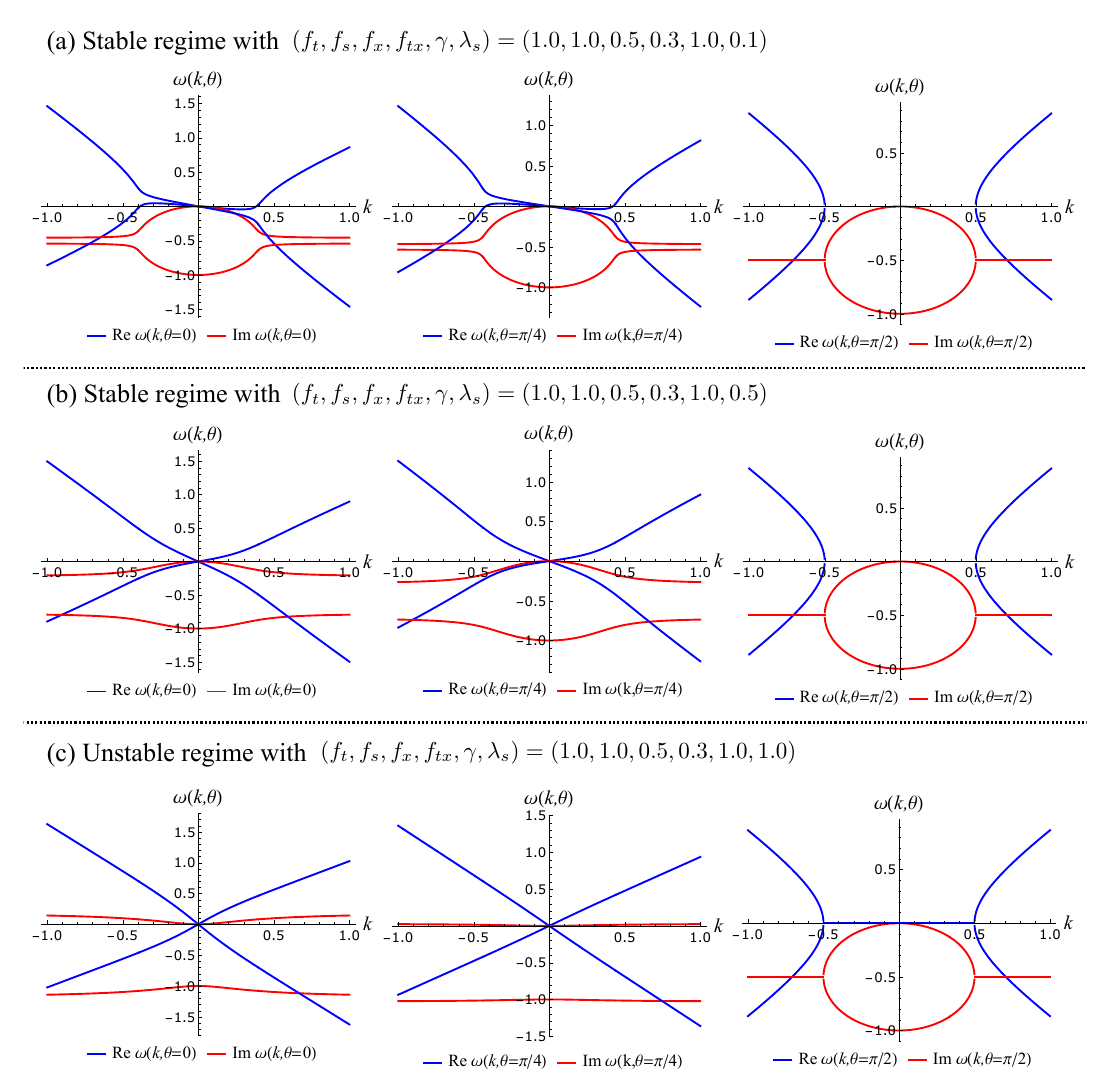
Figure 5: The dispersion relation at three different polar angles in (a)-(b) stable regimes (upper panels) and (c) an unstable regime (a lower